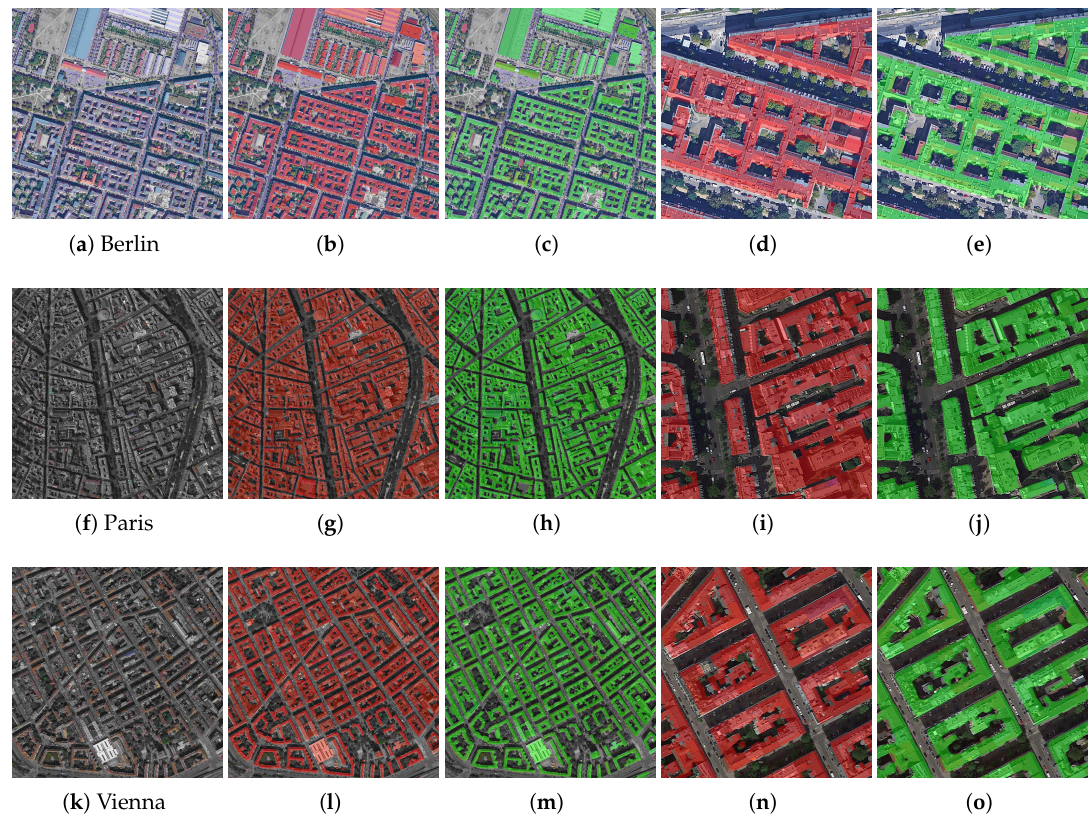
Figure 10. Samples from the cities of Berlin, Paris, and Vienna in area B 2 . The figures of ( a , f , k ) are the sample images, and the figures of ( b , g , l ) colored in red are the ground truth of images. The figures of ( c , h , m ) colored in green are the prediction of GeoBoost. The figures of ( d , i , n ) are the center crop of labels, and the figures of ( e , j , o ) are the center crop of GeoBoost’s prediction. The first three columns are with a size of 4096 × 4096, and the last two is the center crop of the big images for observing details with a size of 1024 ×